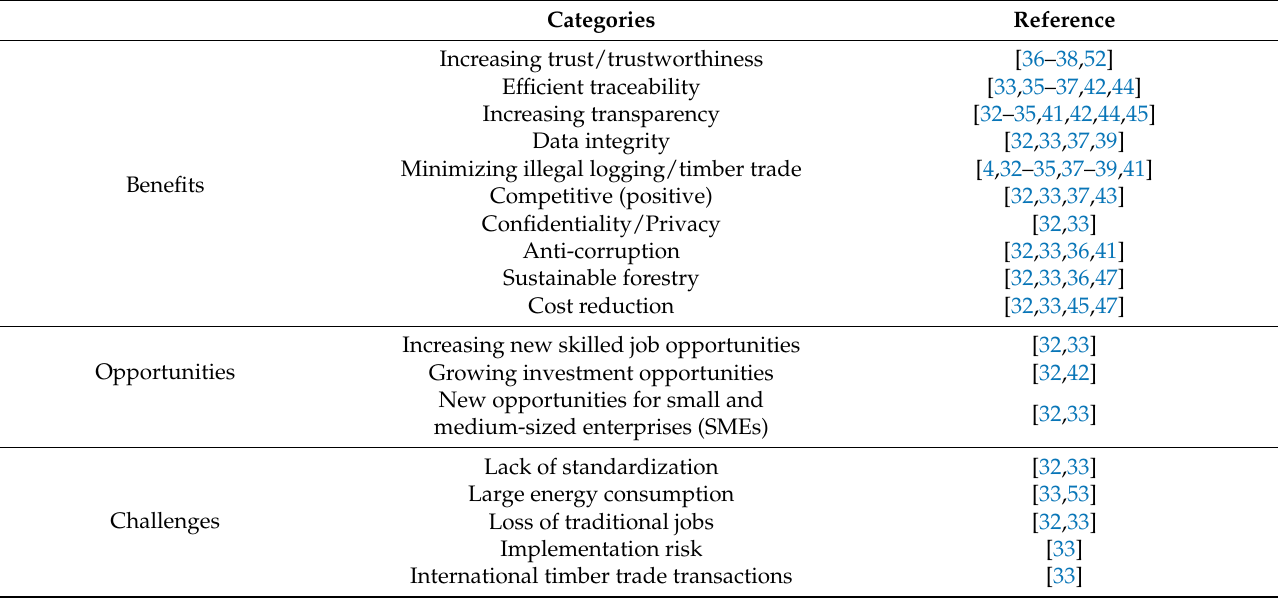
Table 5. Benefits, opportunities, and challenges of blockchain in